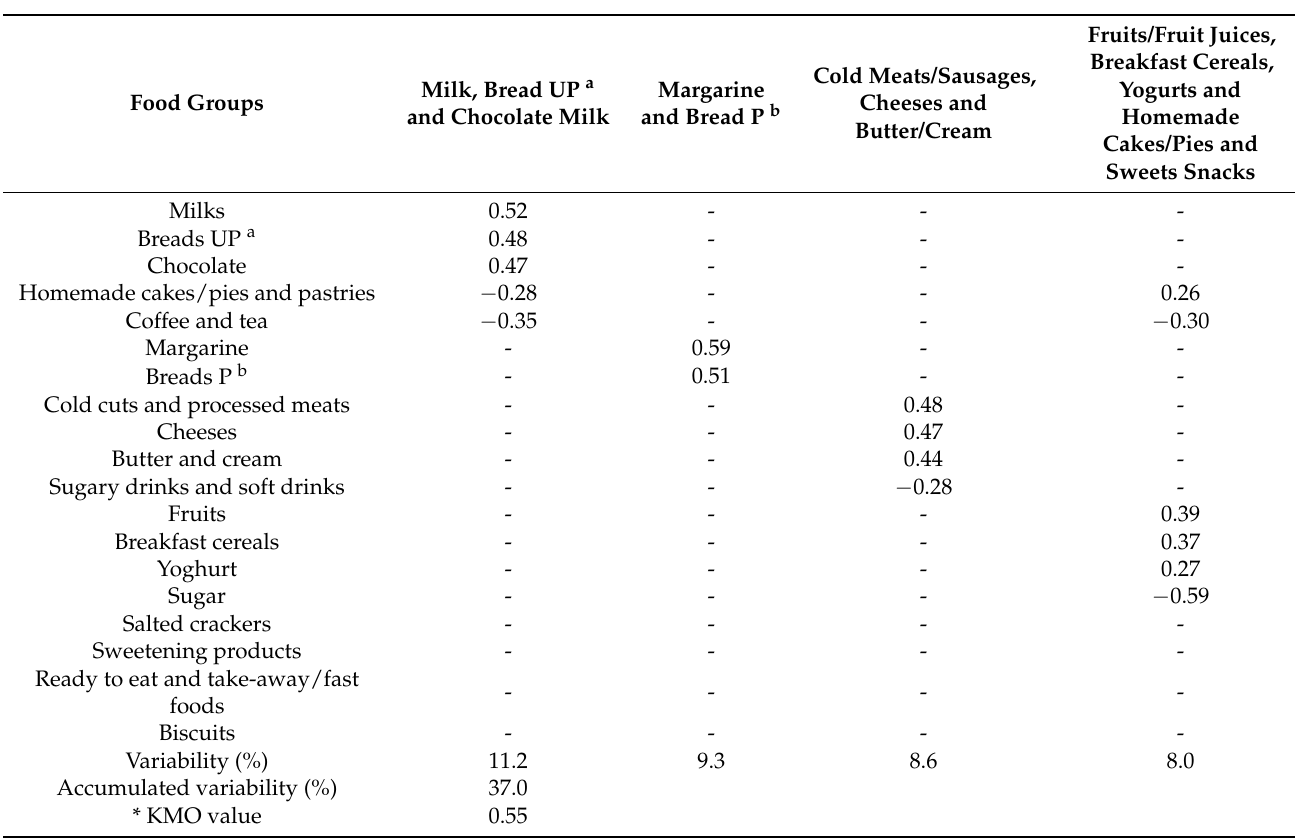
Table 3. Breakfast patterns and rotational factor loadings of the identified food groups of children and adolescents with CHD (n = 169). Brazil